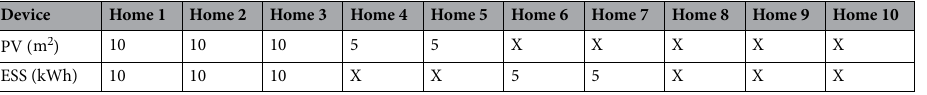
Table 2. PV system and ESS at each home.